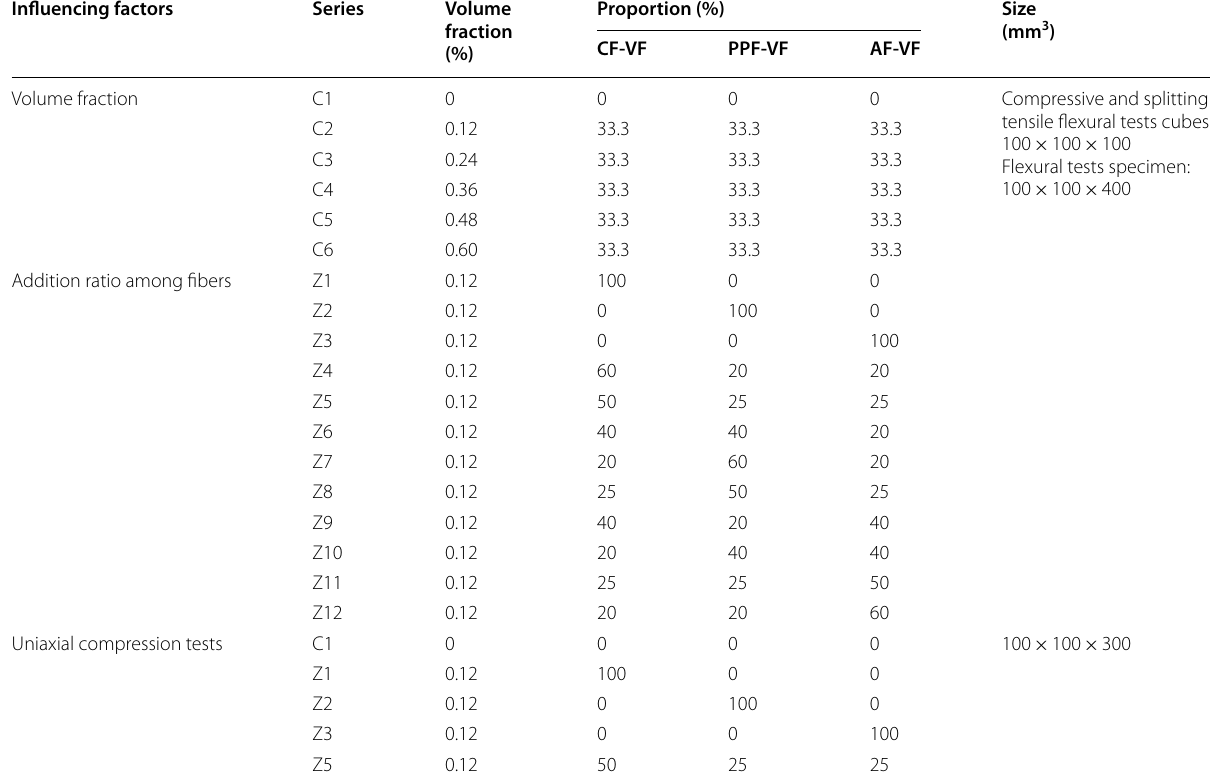
Table 1 Detail of specimens.